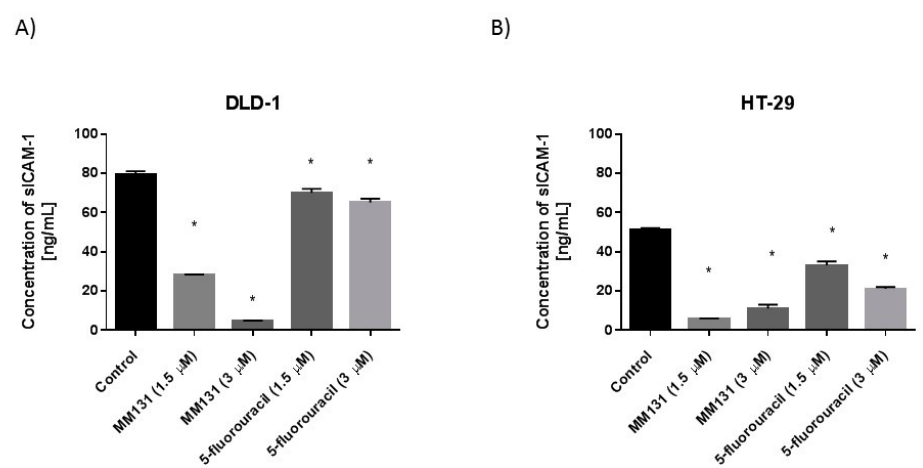
Figure 9. Quantification of sICAM-1 by ELISA. Bar graphs demonstrating sICAM-1 concentration in media from DLD-1 ( A ) and HT-29 ( B ) colorectal cancer cells after 24 h of incubation with MM131 and 5-fluorouracil. n = 3 in duplicates; * p < 0.05 versus respective control group.